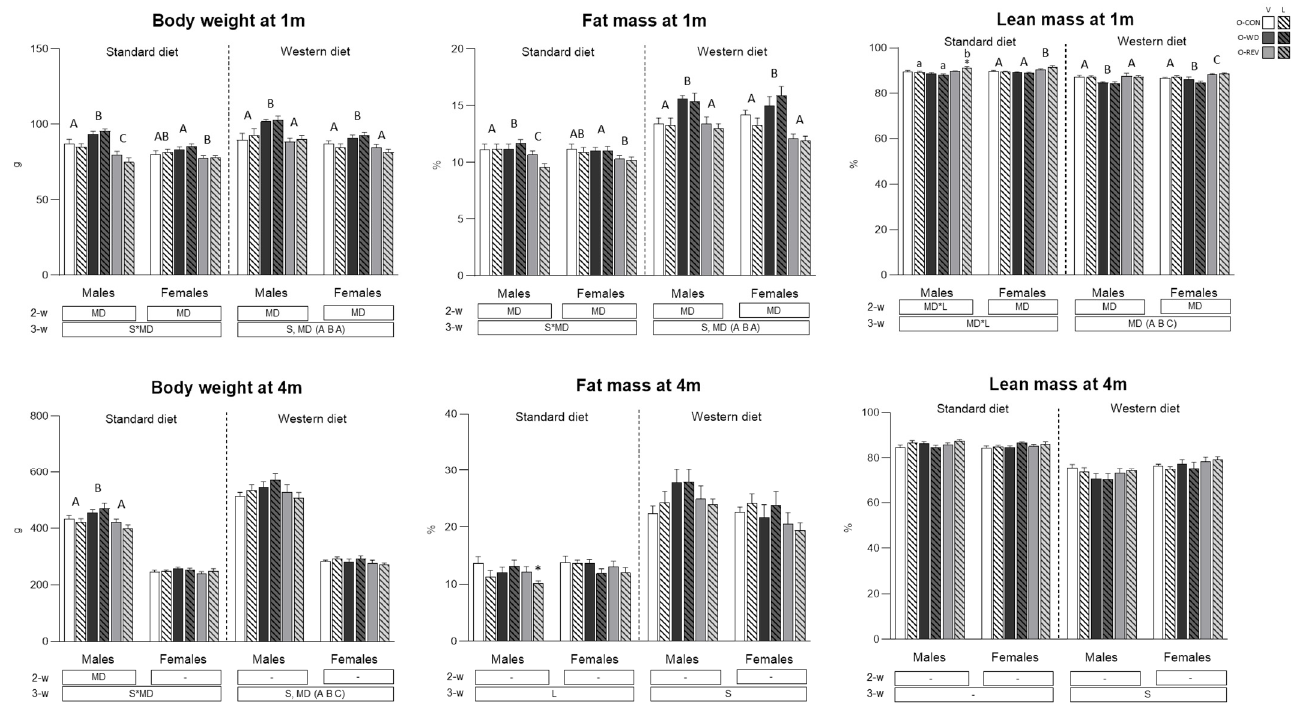
Figure 2. Body weight and composition (fat and lean mass percentage) of O-CON, O-WD and O-REV male and female animals treated with vehicle or leptin during suckling and fed SD or WD from weaning, at one and four months of age. Data are mean ± SEM ( n = 8–12). Statistics: After data separation depending on post-weaning diet, three-way ANOVA was performed to analyze the effect of sex, maternal diet and/or leptin treatment. In each sex, two-way ANOVA was performed to analyze the effect of leptin treatment and/or maternal diet. When an interactive effect was found, one-way ANOVA was performed to analyze the effect of maternal diet in each treatment. Single comparisons between leptin versus vehicle-treated rats of all experimental groups were carried out using Mann-Whitney U test. Symbols: sex (S), maternal diet (MD), leptin treatment (L); A ≠ B ≠ C ( p < 0.05, LSD post-hoc, two-way ANOVA); a ≠ b ( p < 0.05, LSD post-hoc, one-way ANOVA); *, different from their vehicle-treated equal ( p < 0.05, Mann-Whitney U test). Abbreviations: offspring of CON-dams (O-CON), offspring of WD-dams (O-WD), offspring of REV-dams (O-REV), vehicle (V), leptin (L).